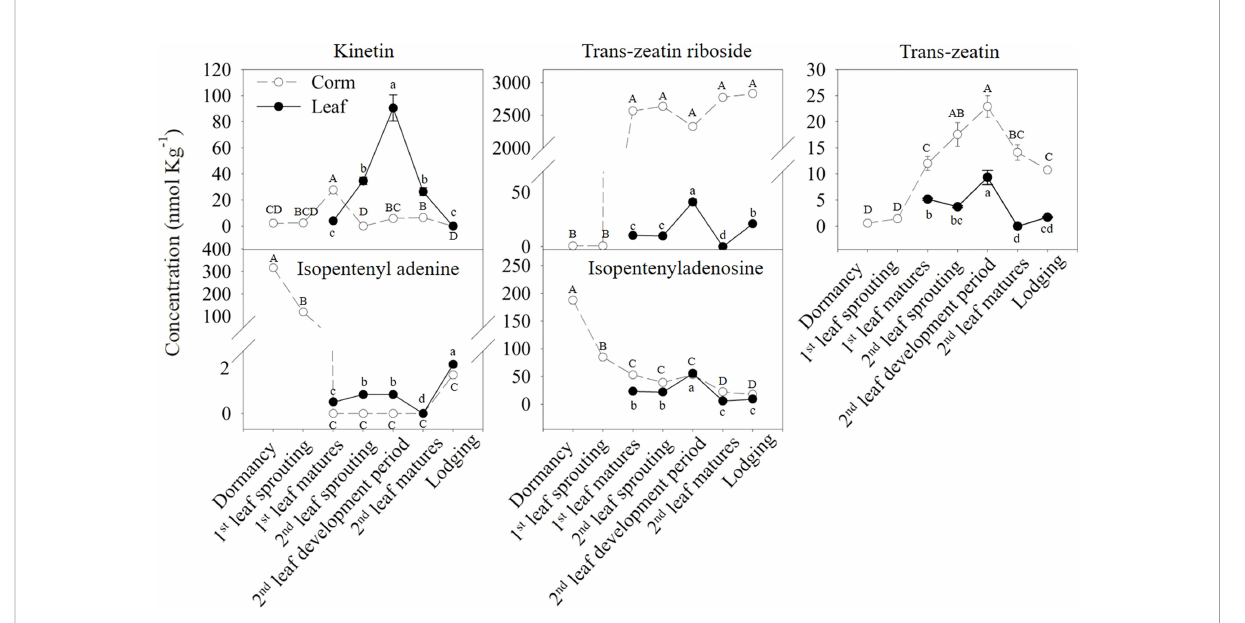
FIGURE 2 Differences in the concentrations of various types of cytokinins in the corms and leaves during the growth cycle of A. muelleri . The dashed lines with white dots represent corms; solid lines with black dots represent leaves. Error bars represent the SE (n=3), and different letters indicate signi fi cant differences compared with different growth periods (P < 0.05, based on ANOVA, followed by Tukey ’ s post-hoc tests for